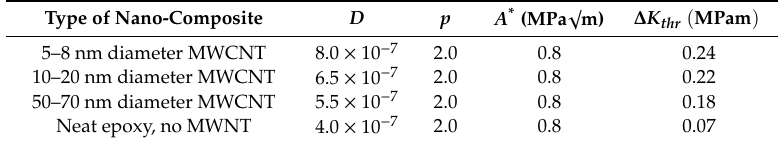
Table 5. Values of the constants employed to compute the da / dN versus ∆ K curves shown in Figure 9. Type of